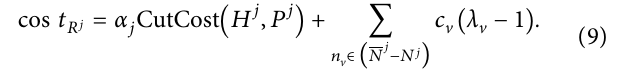
Figure 4: Hypergraph partition model after adding virtual